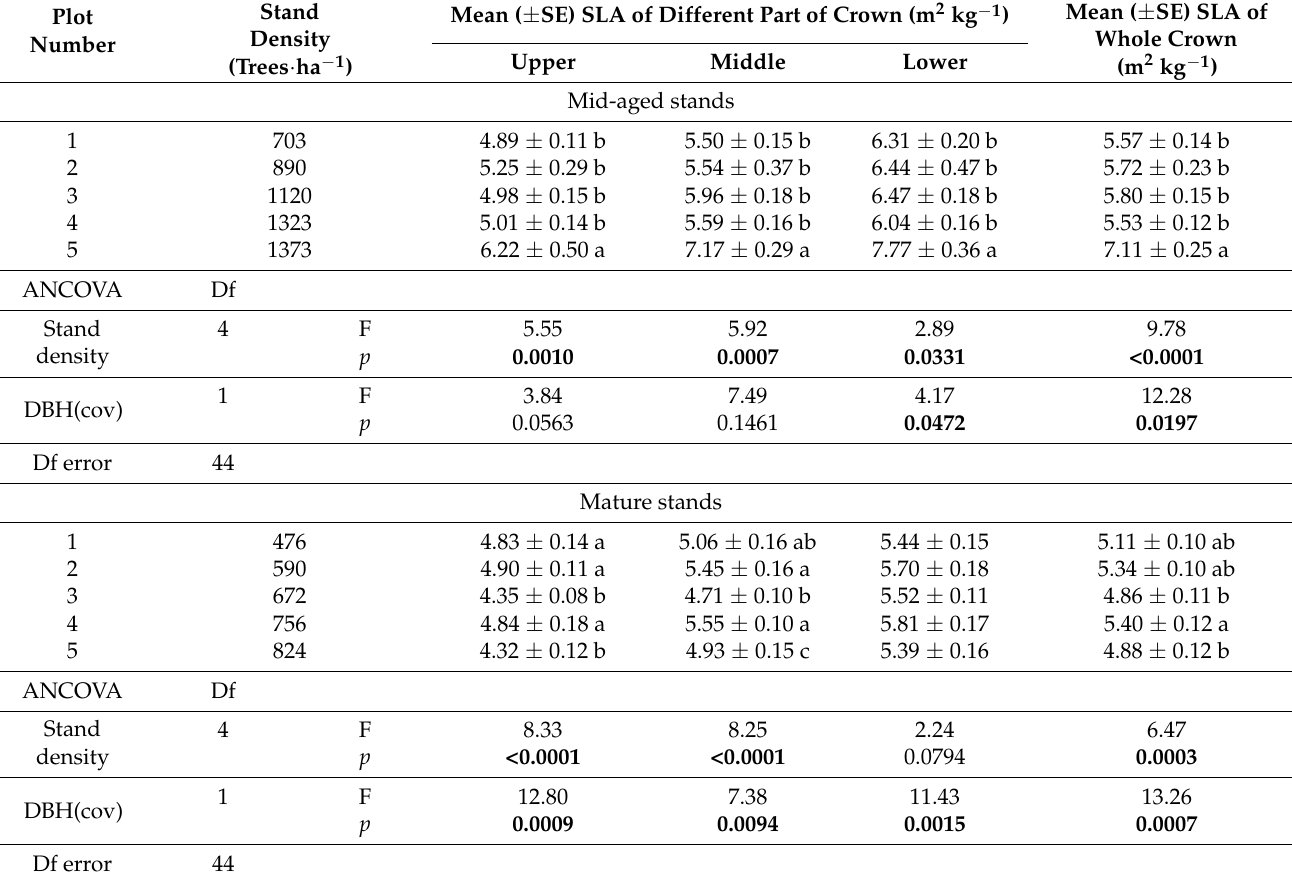
Table 3. The mean SLA of the three parts of the crown (upper, middle, and lower) and the mean SLA of the whole crown for trees growing in stands of different densities. Different letters indicate significant differences (Tukey’s honestly significant difference test) between stands of different densities ( p =